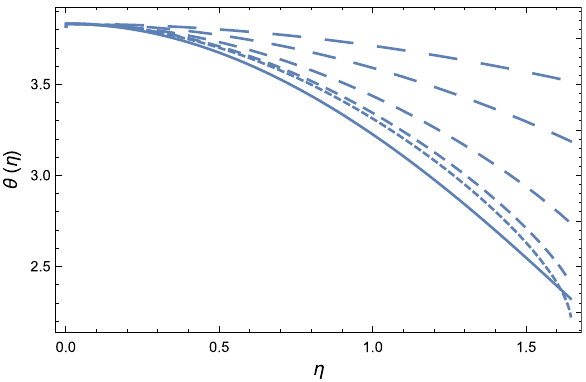
Fig. 1 Variation of the dimensionless density profile θ(η) as a func- tion of the dimensional radial coordinate η of a collapsing rotating Bose–Einstein condensate dark matter halo for different values of the parameter γ 0 : static case with γ 0 = 0, (solid curve), and dynami- cal evolution with γ 0 = 0 (dotted curve), γ 0 = 0 . 25 (short dashed curve), γ 0 = 0 . 50 (dashed curve), γ 0 = 0 . 75 (long dashed curve), and γ = 0 . 90 (long dashed curve), respectively. To numerically integrate 0 the system of equations (136) and (137) we have used the initial con- (η ) = ( 12 /π)η 2 ditions m 0 (η 0 ) = ( 4 /π)η 3 and u (η 0 ) = m (cid:12) , with 0 0 0 0 η